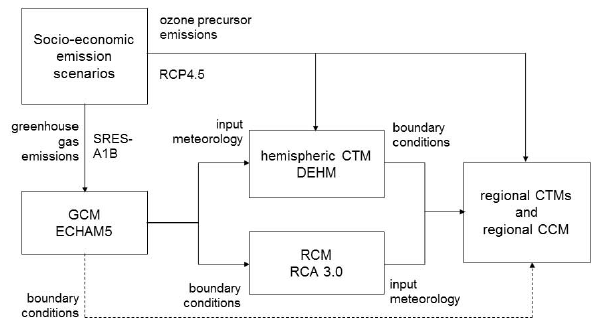
Fig. 1. Model chain used in the study.